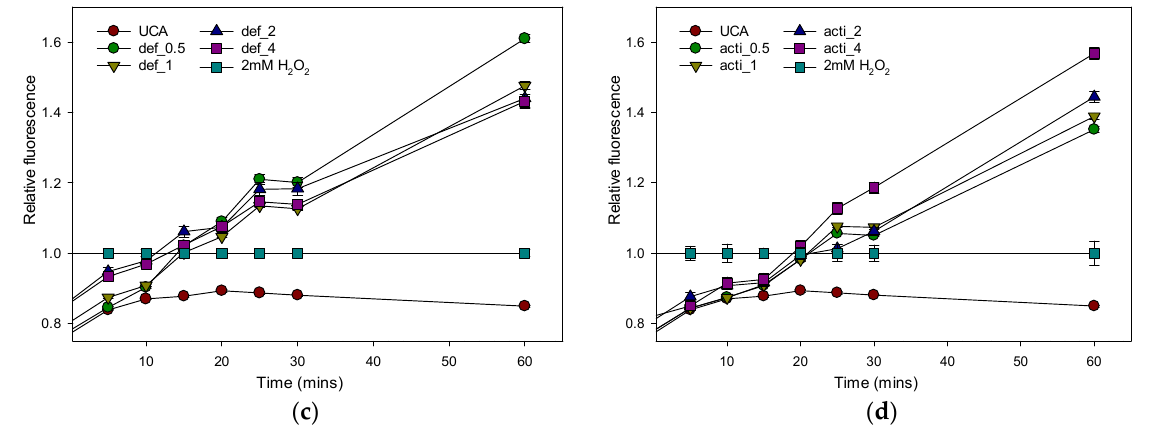
Figure 14. Relative fluorescence of H 2 DCFDA for assessing ROS production in P. aeruginosa and C. albicans treated with recombinant defensin-d2 and actifensin. ( a ) defensin-treated P. aeruginosa ( b ) actifensin-treated P. aeruginosa ( c ) defensin-treated C. albicans ( d ) actifensin-treated C. albicans . The positive control, 2mM H 2 O 2 , was used for normalization of fluorescence. UPA—untreated P. aeruginosa ; UCA—untreated C. albicans ; def—defensin-d2; acti—actifensin. Graphs show means and standard error means (as error bars) of triplicate data per treatment.